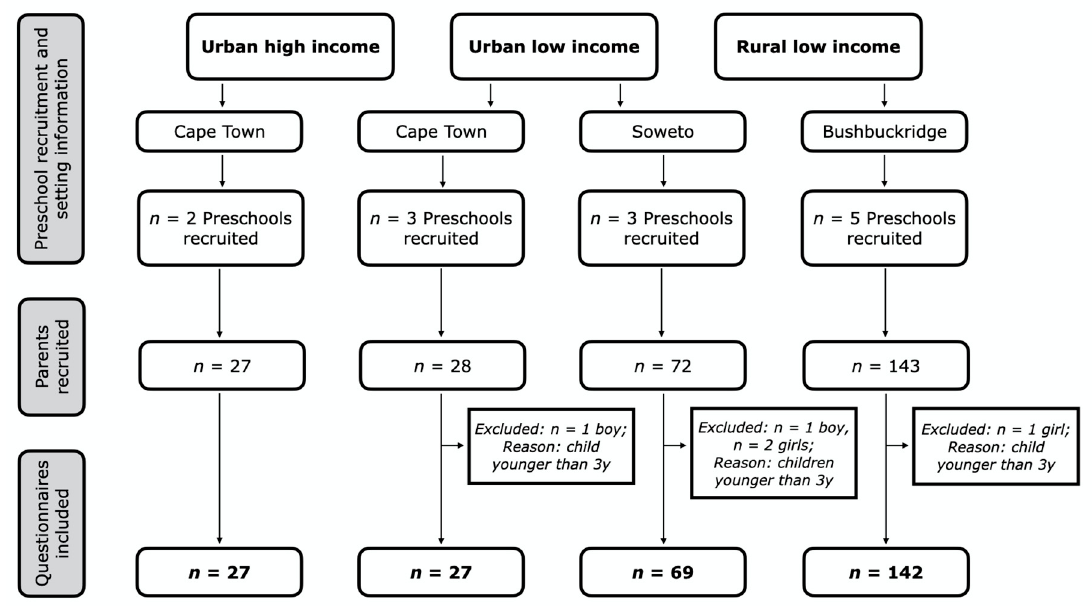
Figure 1. Recruitment details and exclusion for each setting.